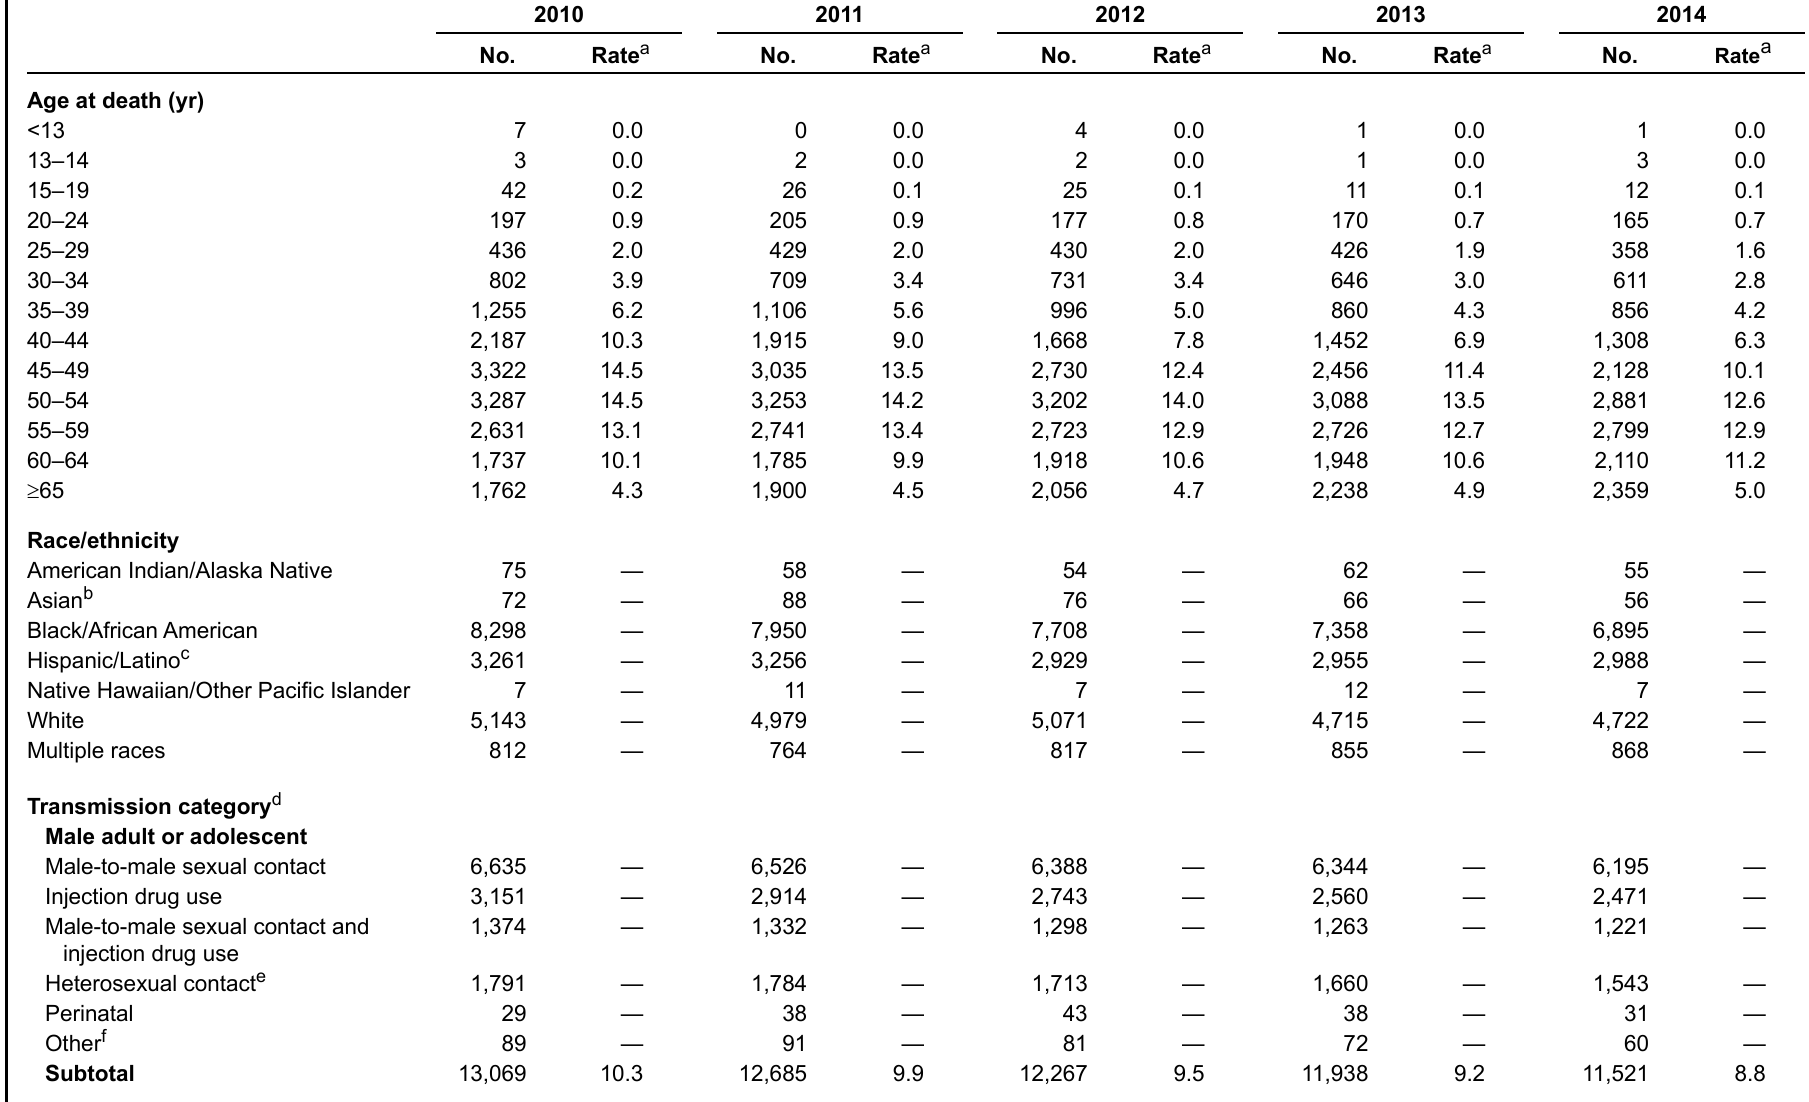
Table 12b. Deaths of persons with diagnosed HIV infection, by year of death and selected characteristics, 2010–2014—United States